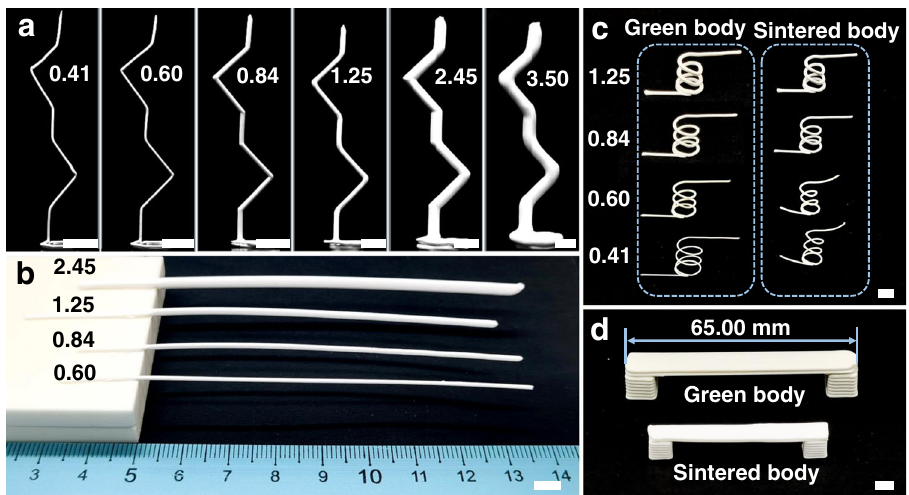
Fig. 4 | The structuralstabilityand fi delity ofthe printed partswere evaluated byNIR-DIW.a Filamentswithdifferentsizenozzles(0.41,0.60,0.84,1.25,2.45,and 3.50mm) cured in-situ with the assistance of NIR. b Optical image showing the shape retention ability of the cantilever fi laments (0.60, 0.84, 1.25, and 2.45mm)